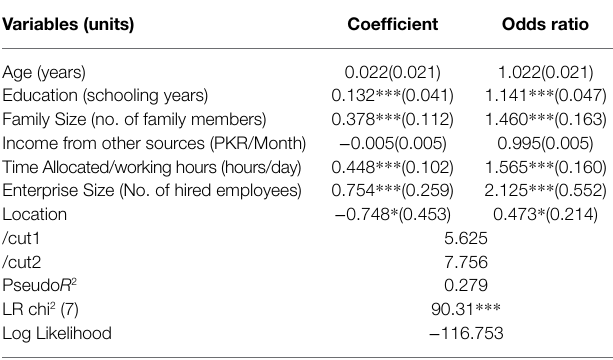
TABLE 4 | Factors effecting contribution of entrepreneurship in household income ( n = 148). Variables